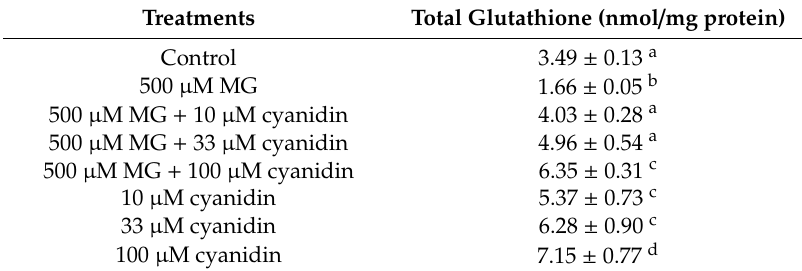
Table 1. E ff ect of cyanidin and its cotreatment with 500 µ M methylglyoxal (MG) for 12 h on Table 1. Effect of cyanidin and its cotreatment with 500 µM methylglyoxal (MG) for 12 h on total total glutathione.